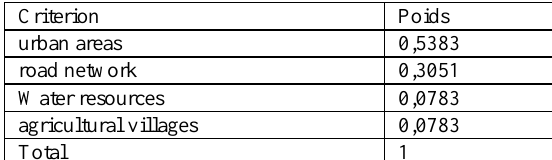
Table 3. Weight values for the different criteria.